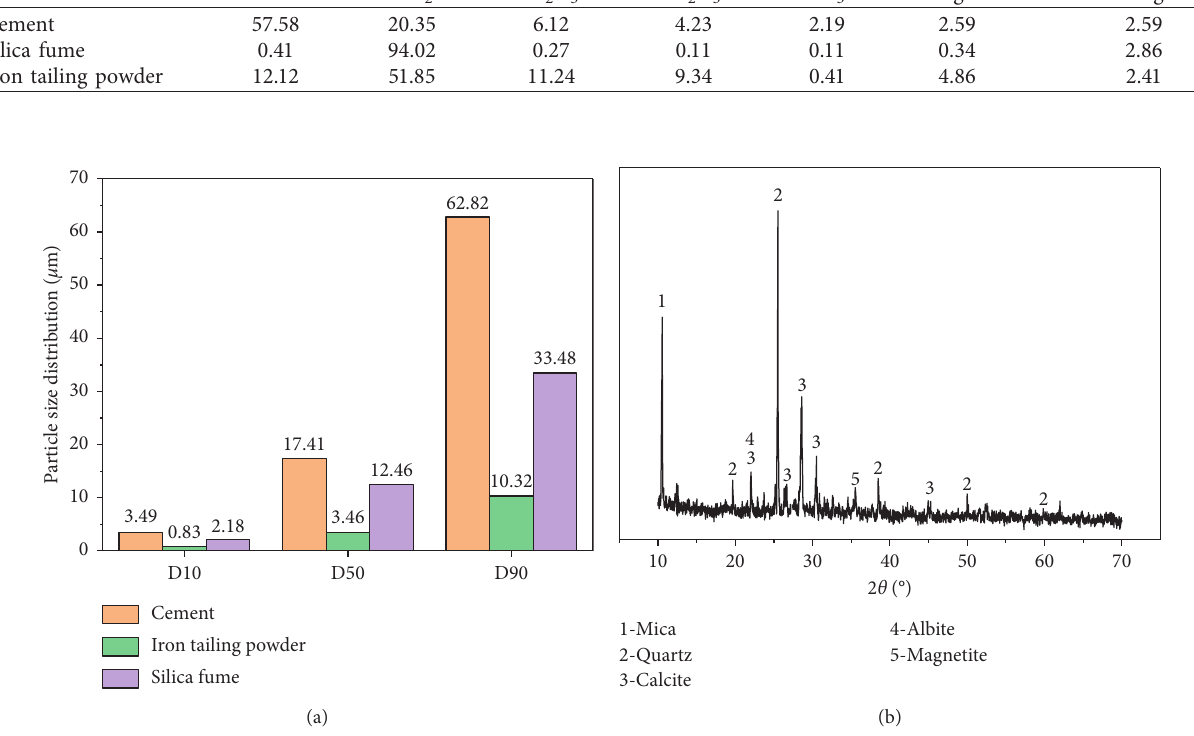
Figure 1: (a) The particle size distribution of raw materials and (b) the XRD patterns of iron tailing powder. Table 3: Mix proportions of UHPC mortar ∗